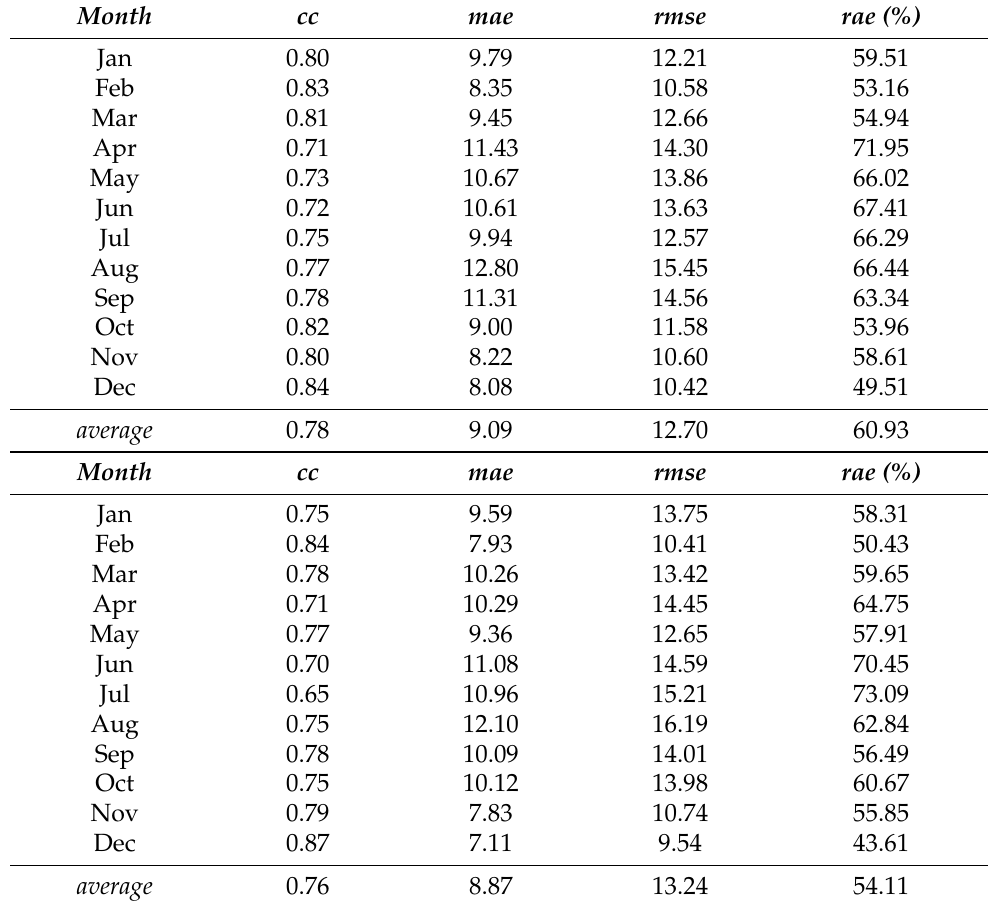
Table 4. Test results, lagged data; linear regression (top), and decision-tree regression (bottom).